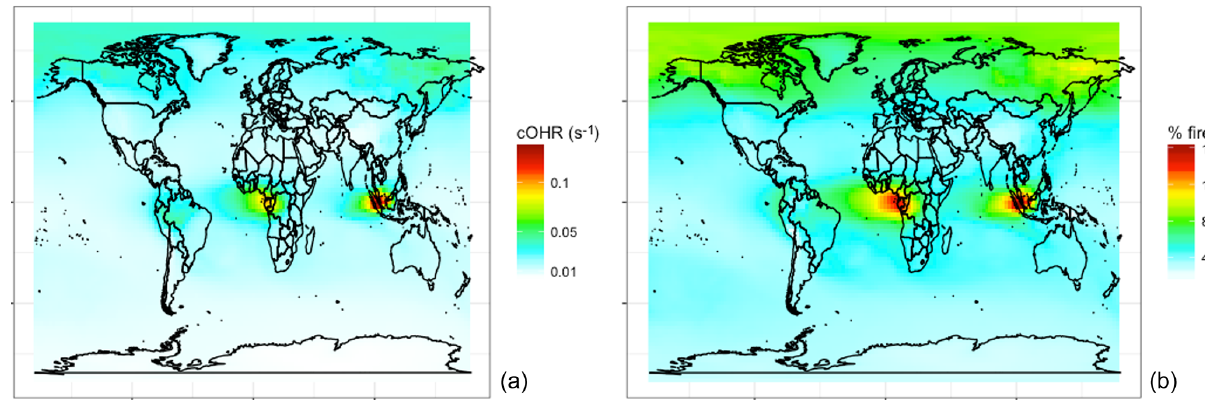
Figure 11. Annual mean simulated (a) fire cOHR and (b) percent of cOHR from fires using GFED4s DM in 2019 at 500hPa.